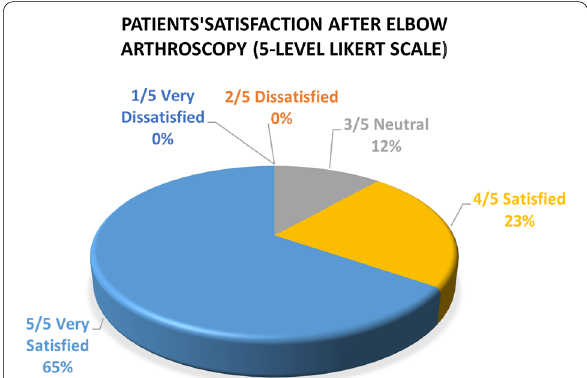
Fig. 2 Patient satisfaction after elbow arthroscopy (five-level Likert scale). Reported patient satisfaction after elbow arthroscopy using five-level Likert scale (follow-up 60 months). No one was dissatisfied with the procedure, three patients were neutral, six were satisfied, and 17 were very satisfied after elbow arthroscopy